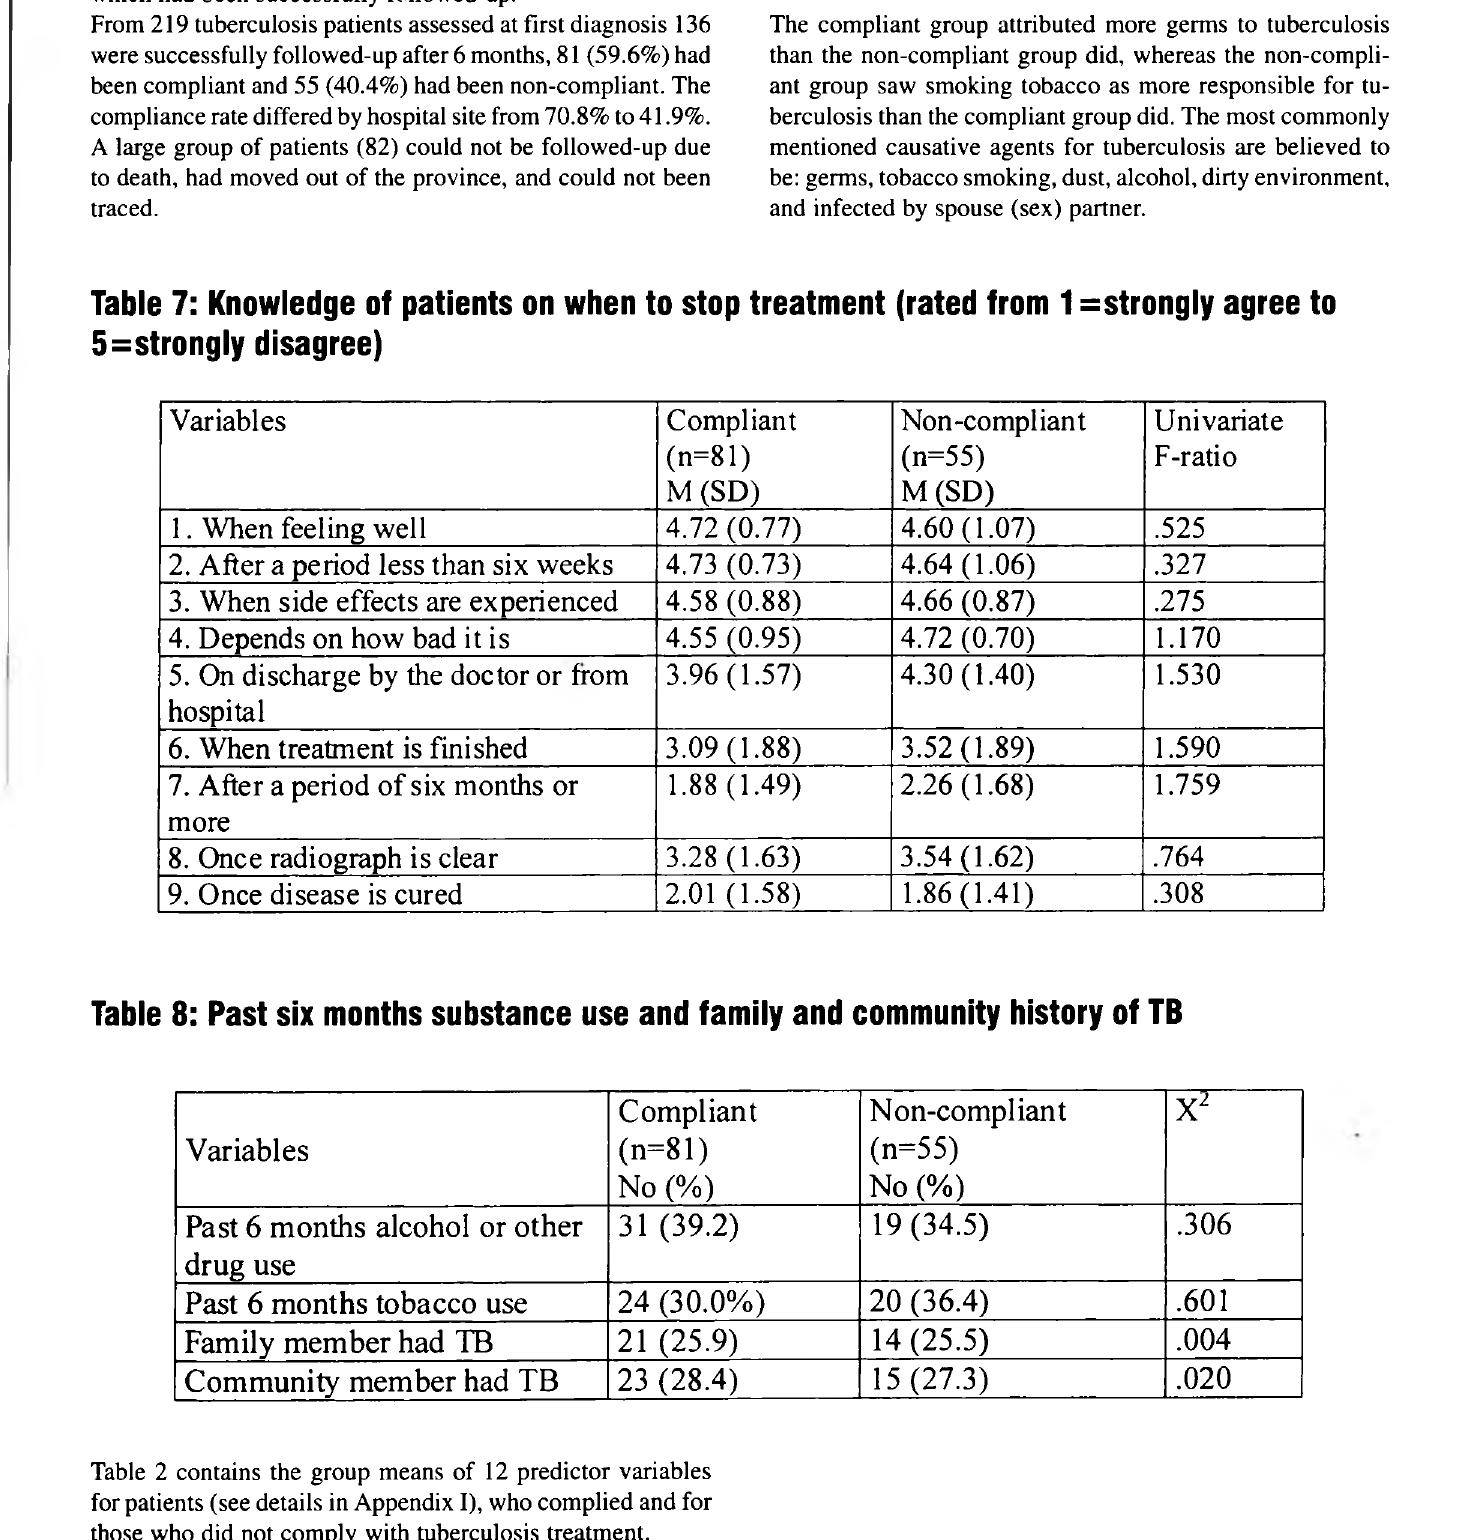
Table 7 : Knowledge of patients on when to stop treatment (rated from 1 = strongly agree to 5=strongly disagree)